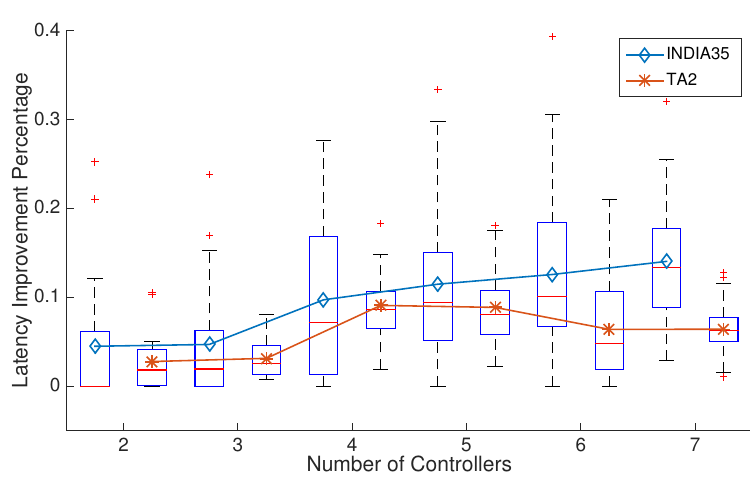
Figure 8. Average SFD-to-controller latency improvement compared with LIA in two different topologies.